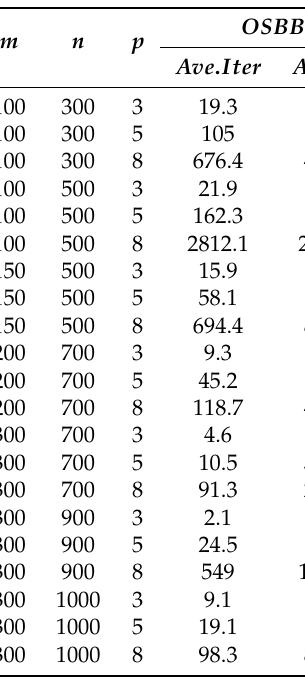
Table 8. The results of random calculations for Example 13.